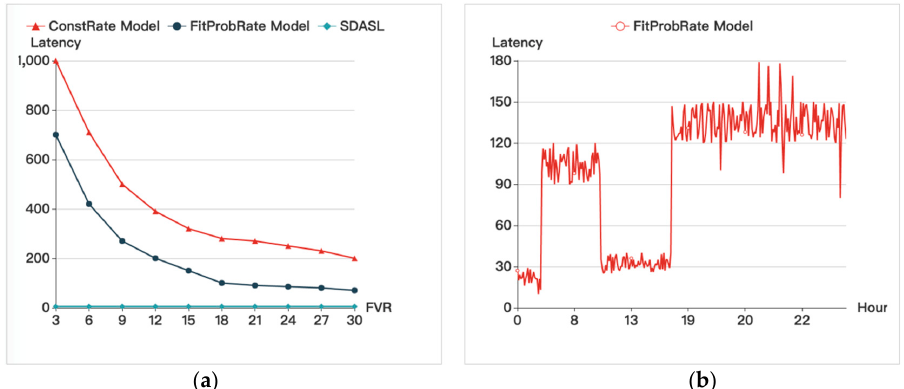
Figure 8. Comparison of latency; ( a ) Description of the change of the Latency which with the change of the FVR; ( b ) Description of the change of Latency of FitProbRate Model which with the change of the hours in a day.